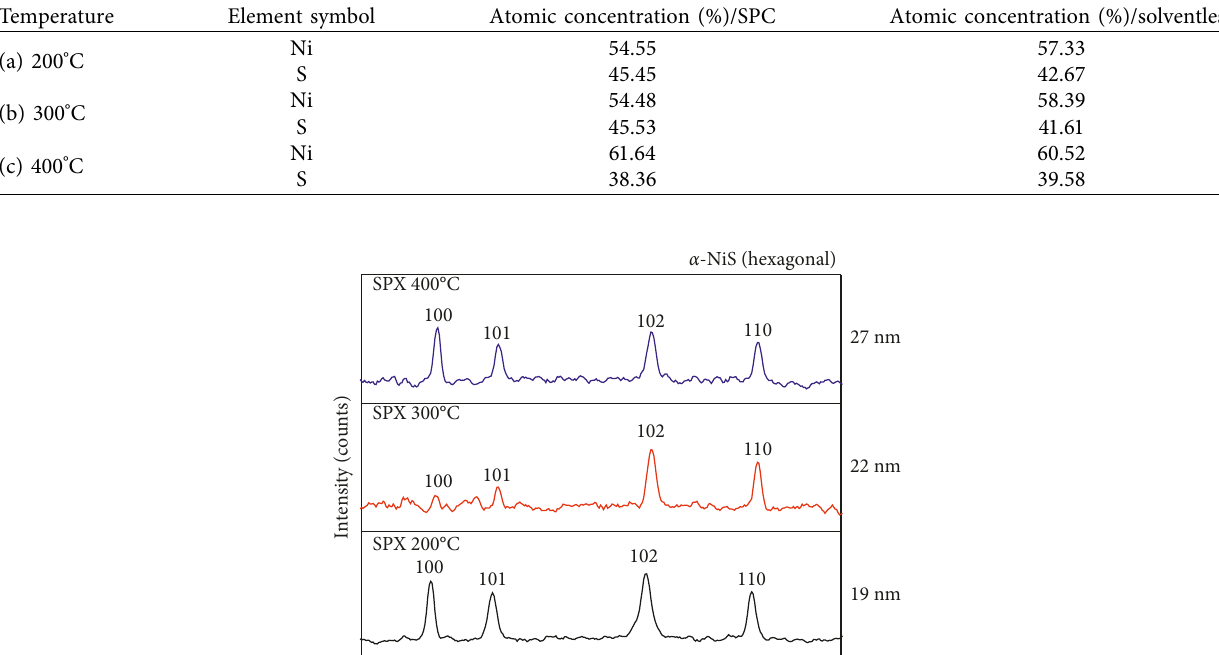
Table 2: EDX of NiS thin films and nanocrystals at 200 ° C, 300 ° C, and 400 ° C.